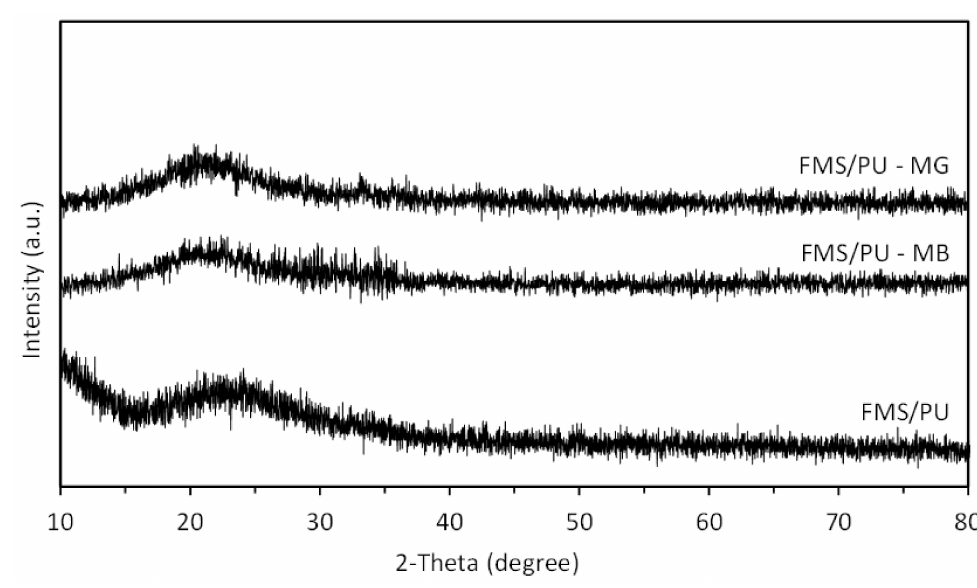
Figure 13. X-ray diffraction of FMS/PU, FMS/PU—MB, and